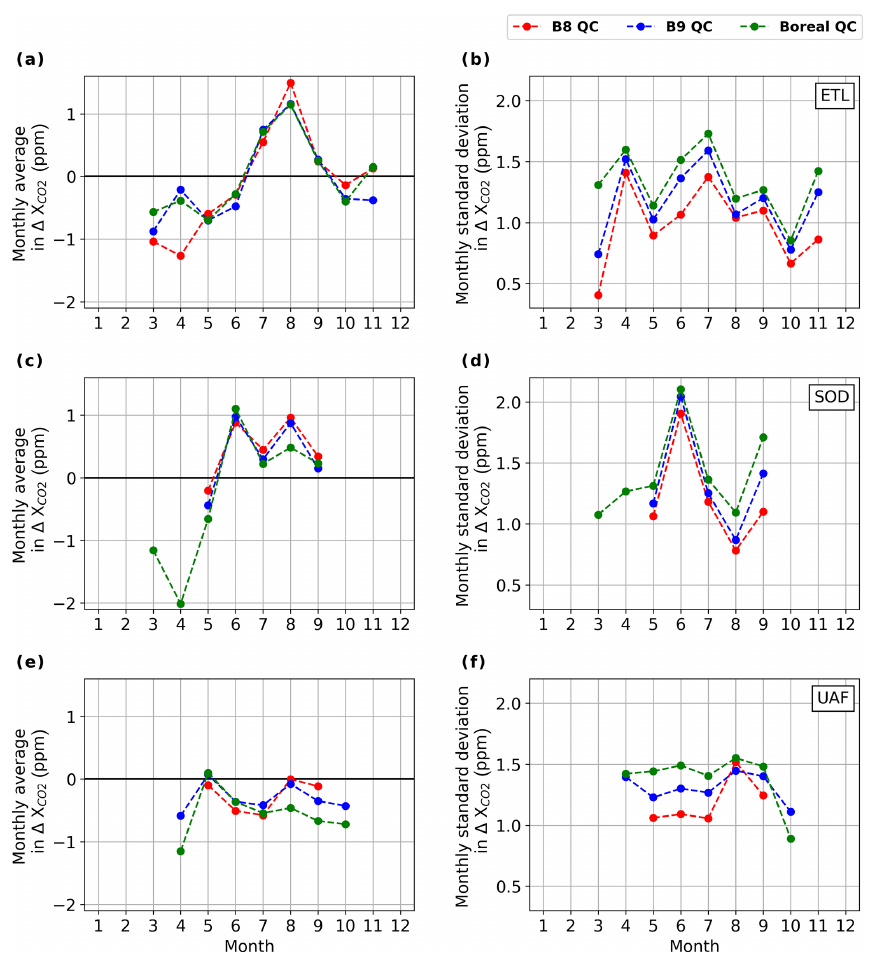
Figure 10. Monthly average bias (a, c, and e) and standard deviation in biases (b, d, and f) of coincident OCO-2 soundings at each of the three boreal forest sites and with each of the QC methods. Note that bias is defined as ( (cid:49)X CO coincident OCO-2